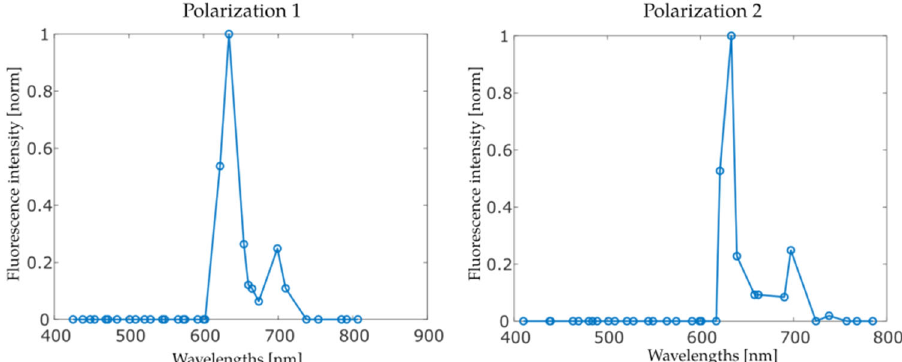
Fig. 2 PpIX spectra acquired with IRIS. IRIS speci fi c PpIX spectra for the two orthogonal polarizations acquired. Each marker represents data from one optical channel.